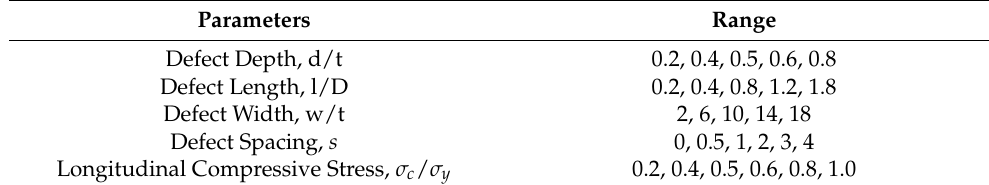
Table 1. Parameters of corrosion defect geometries and external load.